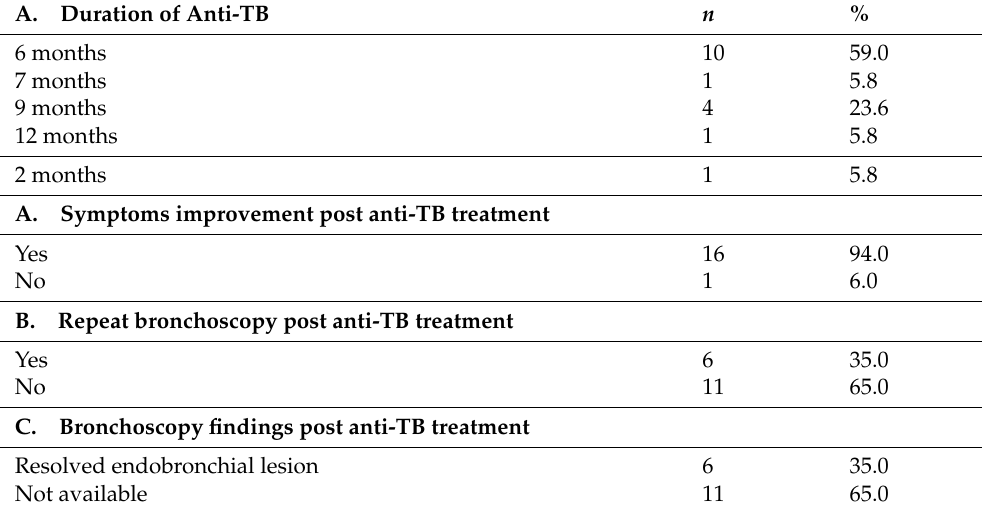
Table 3. EBTB Post treatment